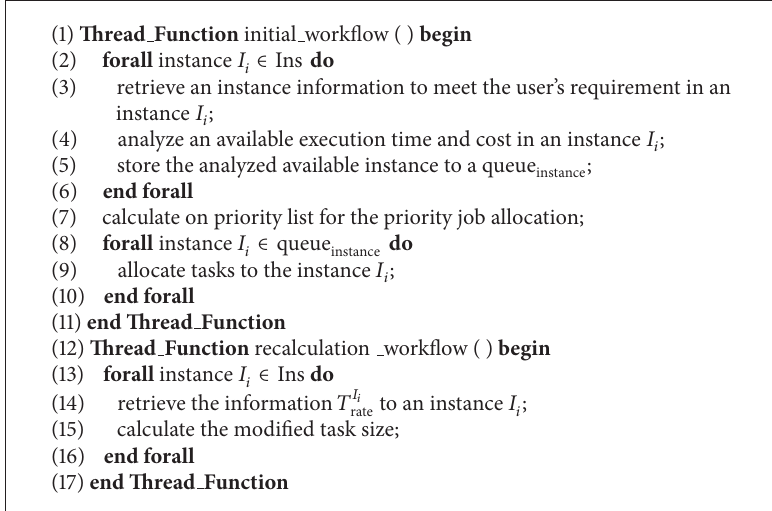
Algorithm 2: Workflow recalculation